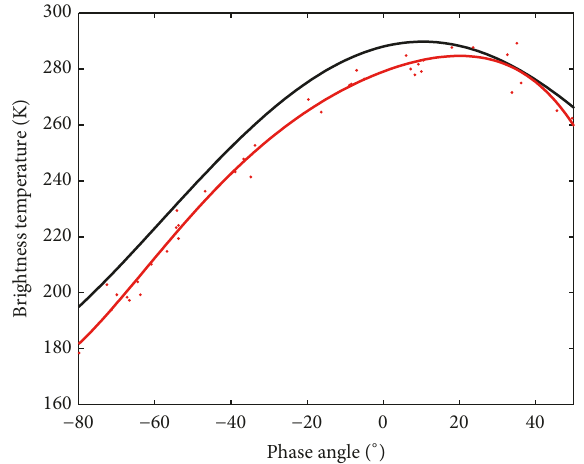
Figure 5: Disk-integrated brightness temperature of the Moon for differentphaseangles relativeto full Moon at157 GHz. Black:Keihm ([13], numbers from web page and personal communication); red: MHS on NOAA-18, single measurements (dots) fitted with polynomial of order five.